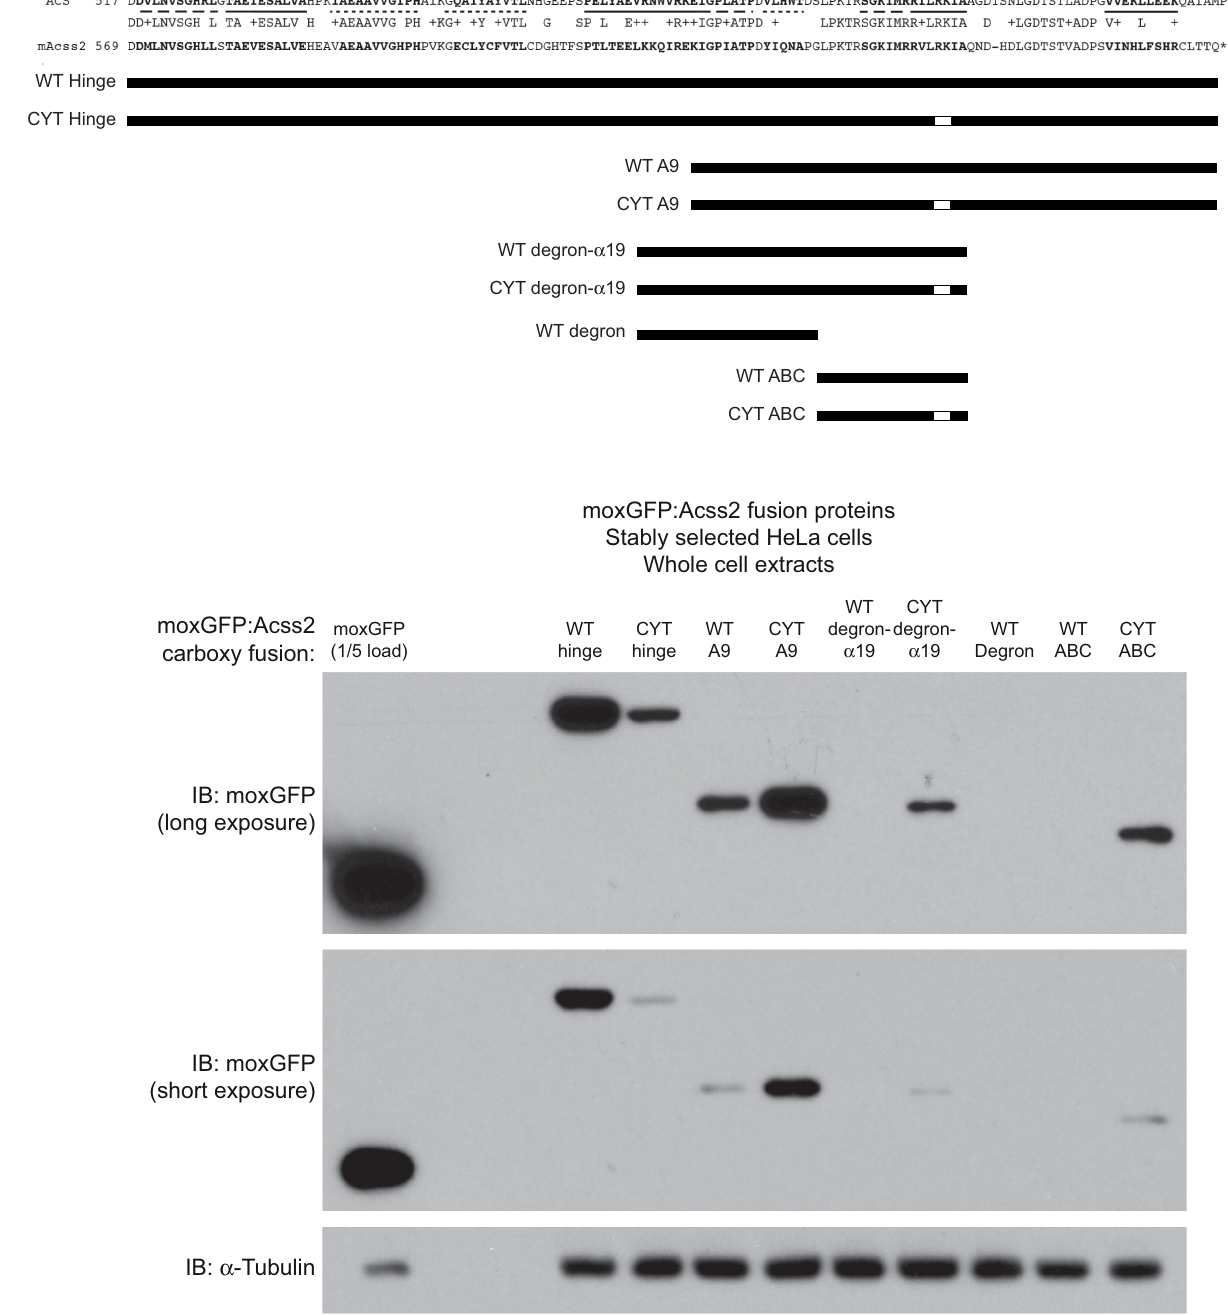
Fig 10. The isolated degron and ABC domains are potent protein destabilization elements. (A) Stable HeLa cell lines expressing select regions of the WT or ED Acss2 carboxy terminal hinge region fused to the carboxy terminus of the green fluorescent protein moxGFP were generated by lentiviral transduction followed by drug selection. (B) The moxGFP:Acss2 fusion proteins were examined by immunoblot to assess relative protein levels. Because the level of parental moxGFP fusion protein in a stable cell line was substantially higher than levels of all moxGFP:Acss2 fusion proteins examined, the amount of protein extract loaded from the moxGFP only stable cell line was one-fifth that of the stable moxGFP:Acss2 fusion protein cell lines as reflected in the reduced immunoblot signal for the comparison protein, α